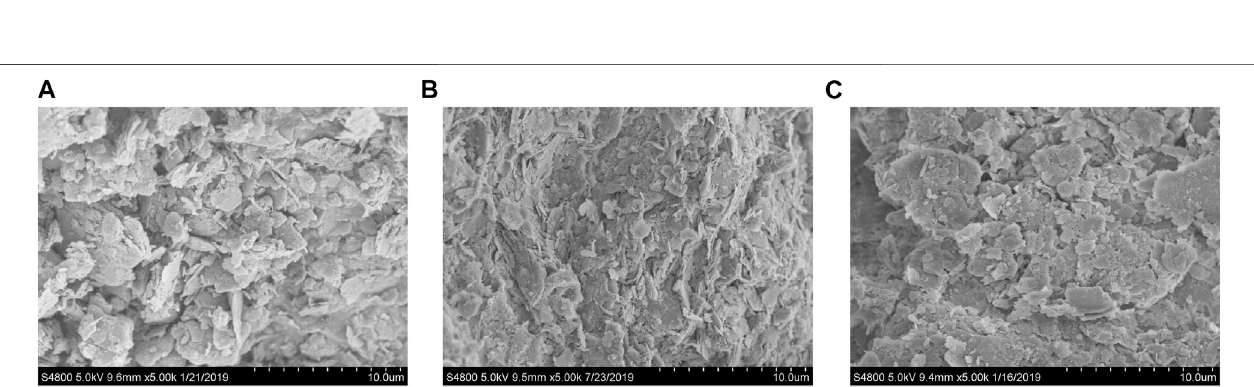
FIGURE 8 | SEM images of solidi fi ed muddy soil with different cement contents (A) Cement content (1:30) (B) Cement content (1:25) (C) Cement content (1:20).